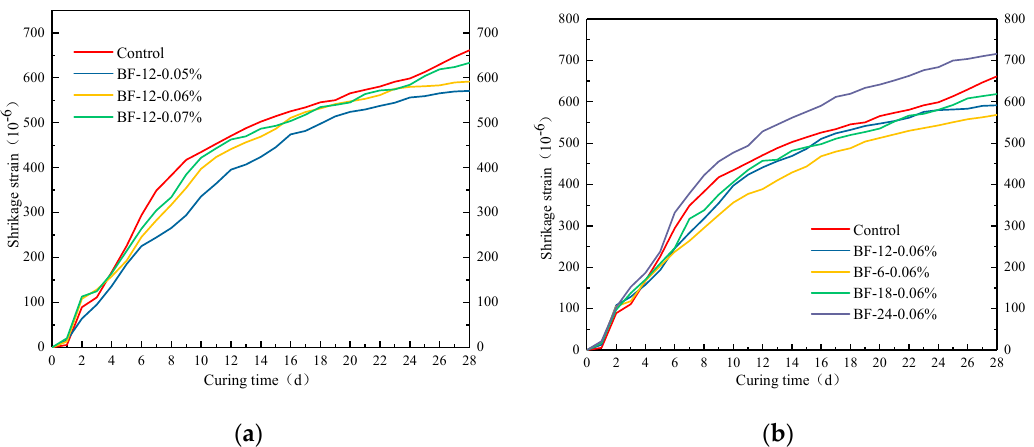
Figure 13. Drying shrinkage development curve of BFRCs ( a ) with different fiber content; ( b ) with different fiber length.